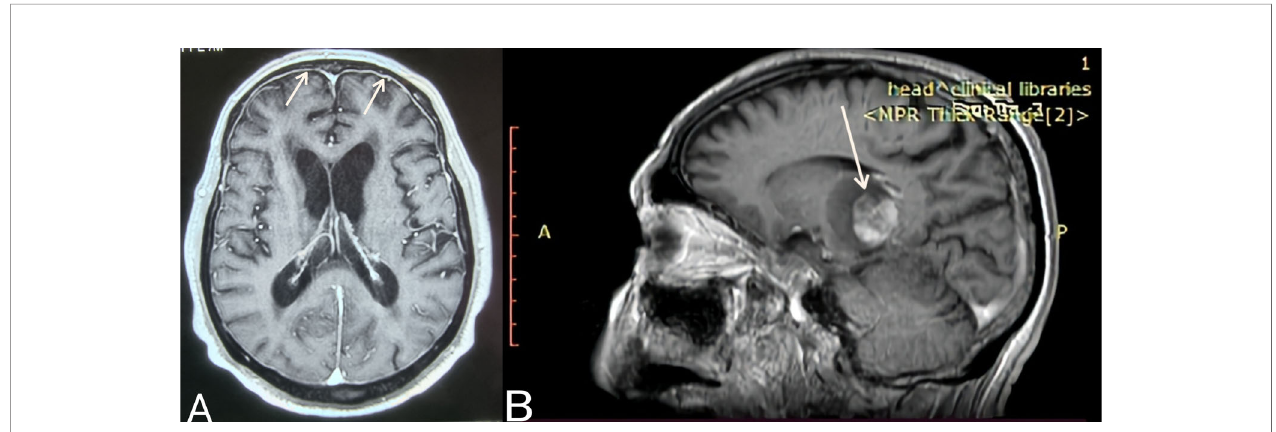
FIGURE 1 | (A) Case 3: Axial T1 MR image (gadolinium enhanced) showing meningeal enhancement-diffuse form of BNS (white arrows). (B) Case 4: Sagittal T1 MR image (gadolinium enhanced) showing a brain mass- tumoral form of BNS (white